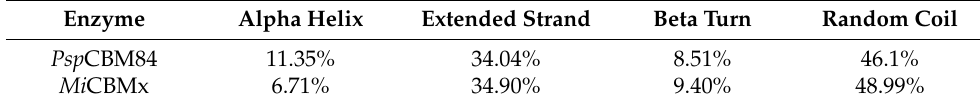
Figure 2. Structure properties of Mi CBMx and Psp CBM84. ( a ) The structure of Psp Xan9 (6fhj), in which the blue part is the structure of Psp CBM84. ( b ) The prediction three dimensional structure of Mi CBMx. ( c ) Three-dimensional structure comparison of the Psp CBM84 (blue) and Mi CBMx (green). The calcium ions are shown as cyan spheres, sodium as purple [13]. Table 1. Structural information of Psp CBM84 and Mi